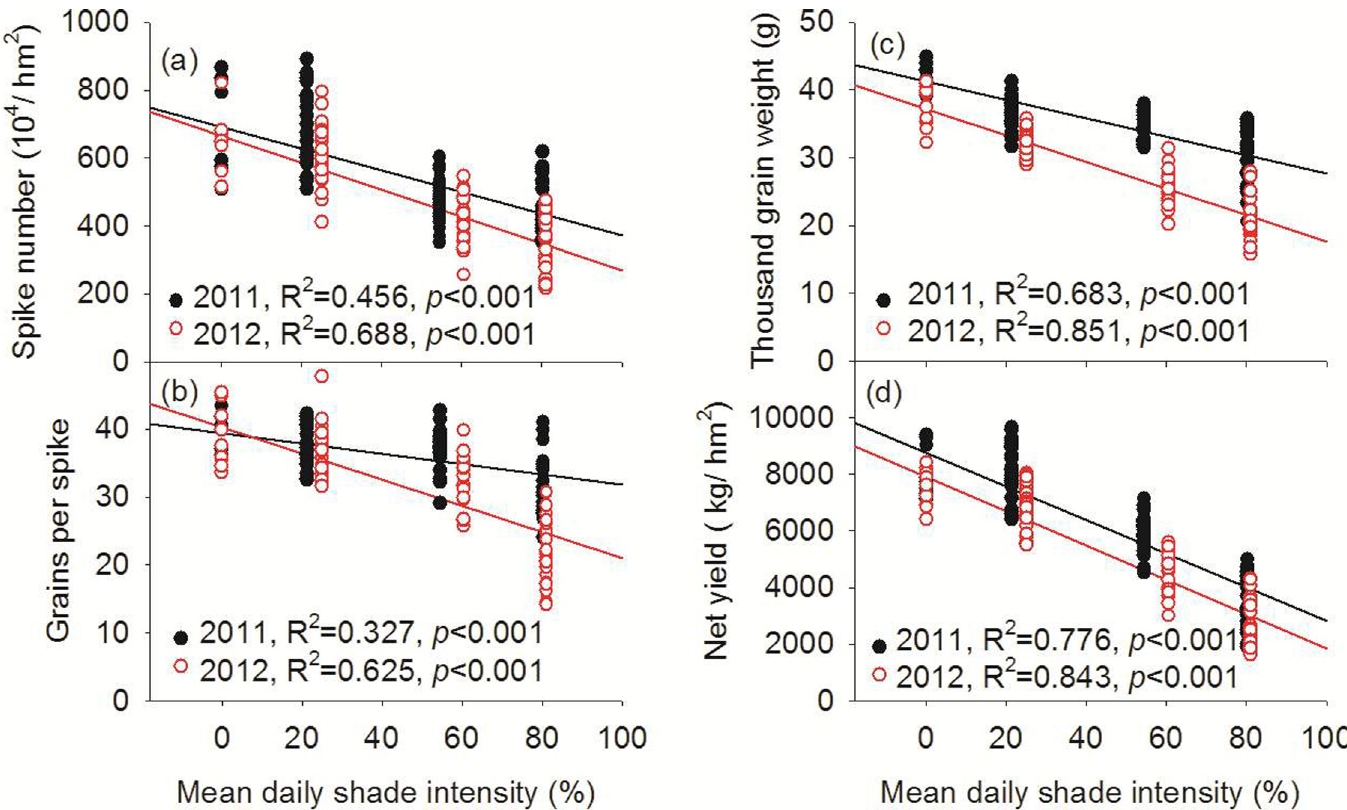
Fig 5. Relationship between the spike number (a), grains per spike (b), thousand grain weight (c) and net yield (d) with mean daily shade intensity of wheat in 2011 and 2012.